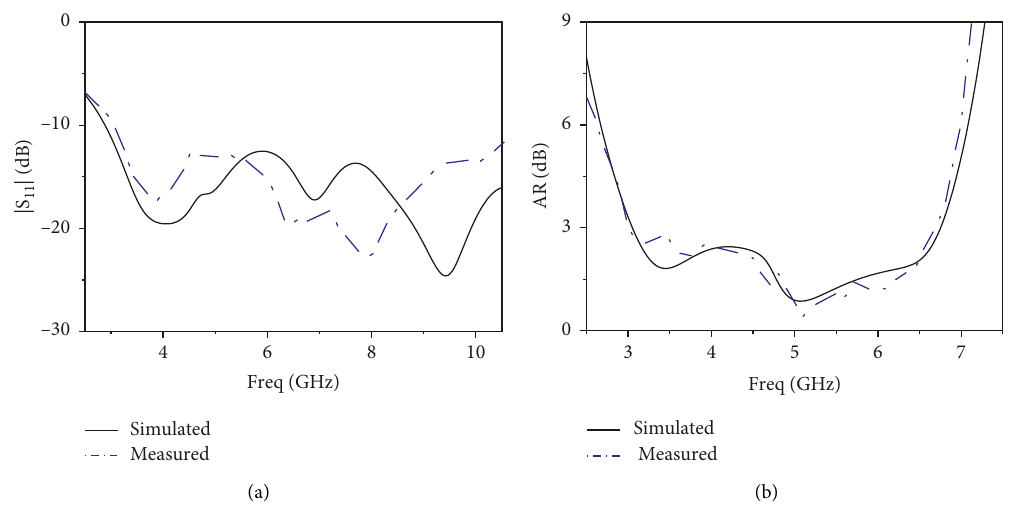
Figure 6: Simulated and tested | S 11 | and AR results of the CPMA. (a) | S 11 | curves and (b) AR curves.